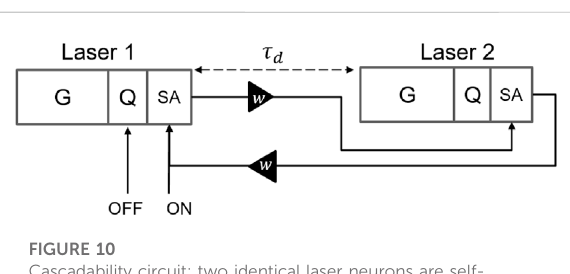
FIGURE 10 Cascadability circuit: two identical laser neurons are self- coupled with a delay of τ d = 2ns and a gain of 7 dB ( w =